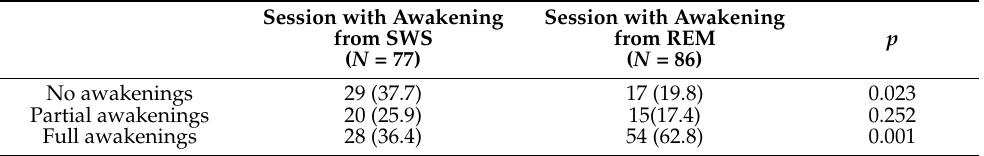
Table A2. Types of awakenings according to their completeness in sessions with SWS and